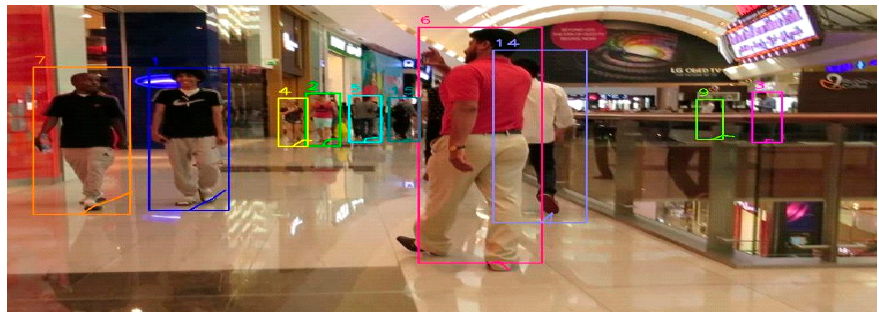
Figure 8. The result of applying the proposed tracker on MOT 16-11.